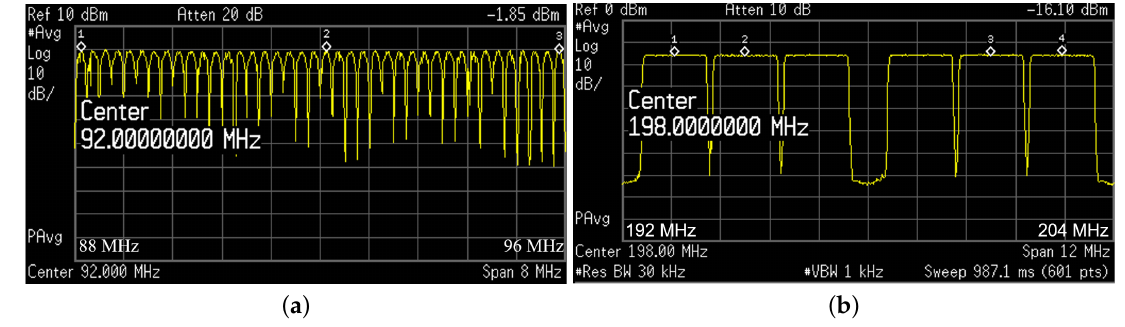
Figure 14. Multichannel simulation. ( a ) FM signals, 88 ∼ 96 MHz, bandwidth = 80 kHz and ( b ) DMB signals, 192 ∼ 204 MHz, bandwidth = 1.6 MHz in parallel.